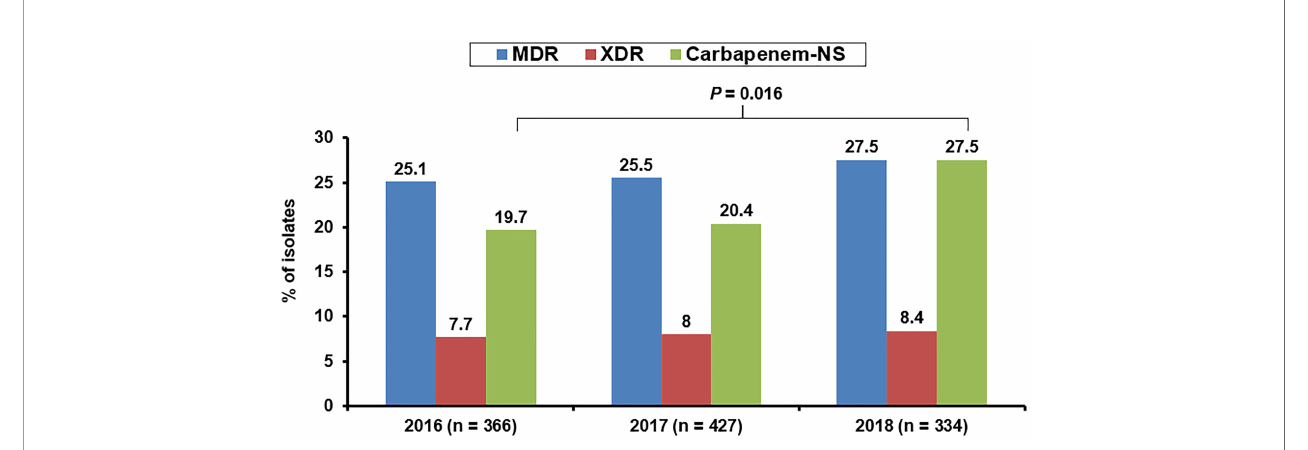
FIGURE 1 | Annual rates of non-susceptibility to any anti-pseudomonal carbapenem agent among Pseudomonas aeruginosa cultured from three infection sources (respiratory tract, abdomen, and urinary tract) of patients hospitalized in Taiwan between 2016 and